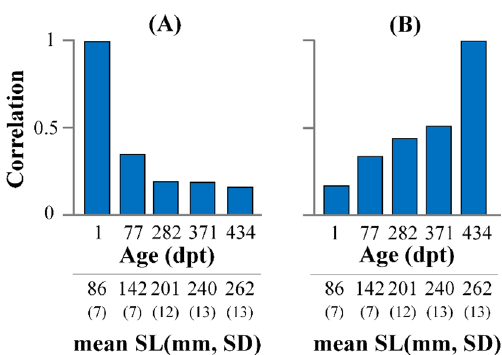
Figure 2. ( A ) Pearson’s correlation coefficients between the Procrustes distances of the juvenile stage (1 dpt) with the Procrustes distances of the next sampling points, up to the end of the on-growing period (434 dpt). ( B ) Pearson’s correlation coefficients between the Procrustes distances at the end of on-growing (434 dpt) with the Procrustes distances of the previous sampling points, up to the beginning of on-growing period (1 dpt). The average standard length (SL) of each sample is given. All estimated correlations were significant ( P <